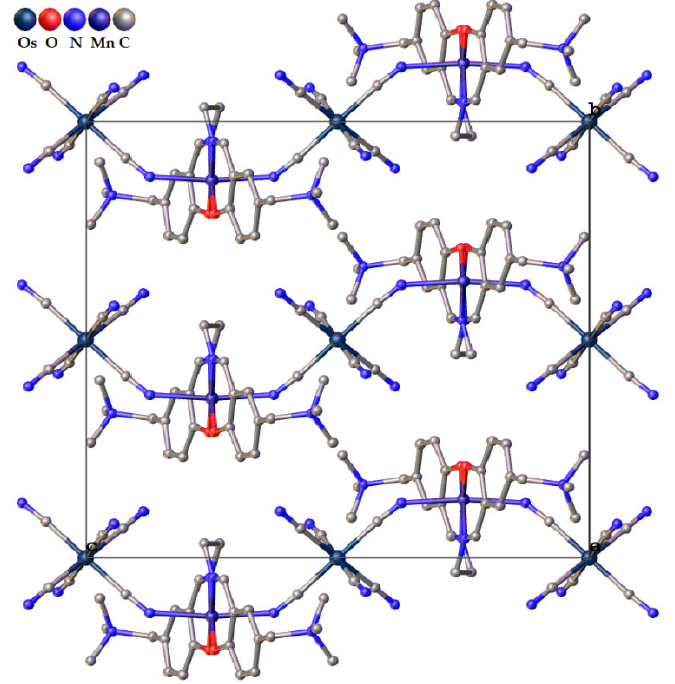
Figure 1. ORTEP view of the structure of 1 , showing the atom ‐ labeling scheme. Displacement ellipsoids are drawn at the 50% probability level.